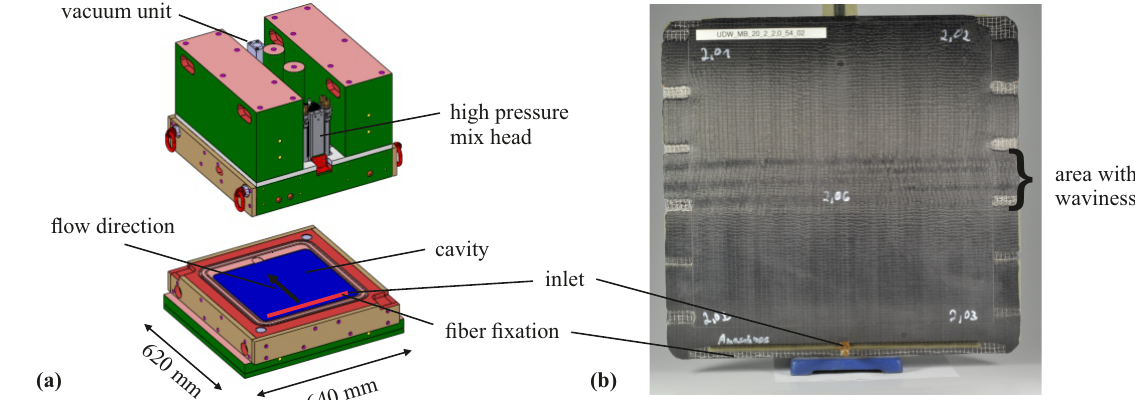
Figure 5. Resin-transfer molding tool ( a ) and plate with imposed fiber waviness with an A / λ = 0.06 ratio ( b ).